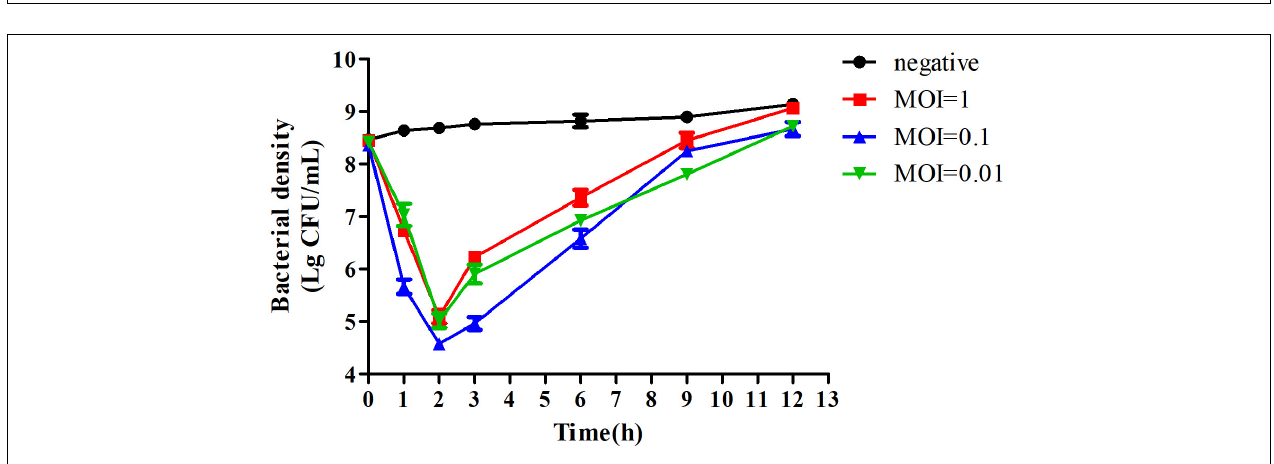
FIGURE 4 | Evolutionary characteristics of PZL-Ah152. (A) Phylogenetic tree analysis of PZL-Ah152. (B) Multiple genome alignments among PZL-Ah152 and other homologous phages. Similarity is indicated by the height of the bars, complying with the average level of conservation in that region of the genome sequence. The homologous phages are marked in the picture. (C) Collinearity analysis of phage PZL-Ah152 with other phages.